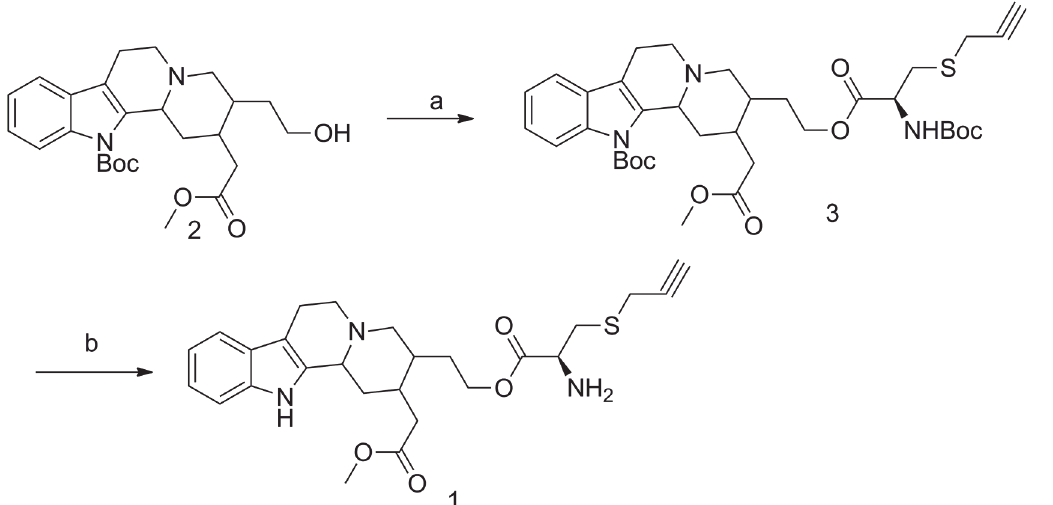
Fig 1. The synthetic route of compound 1.